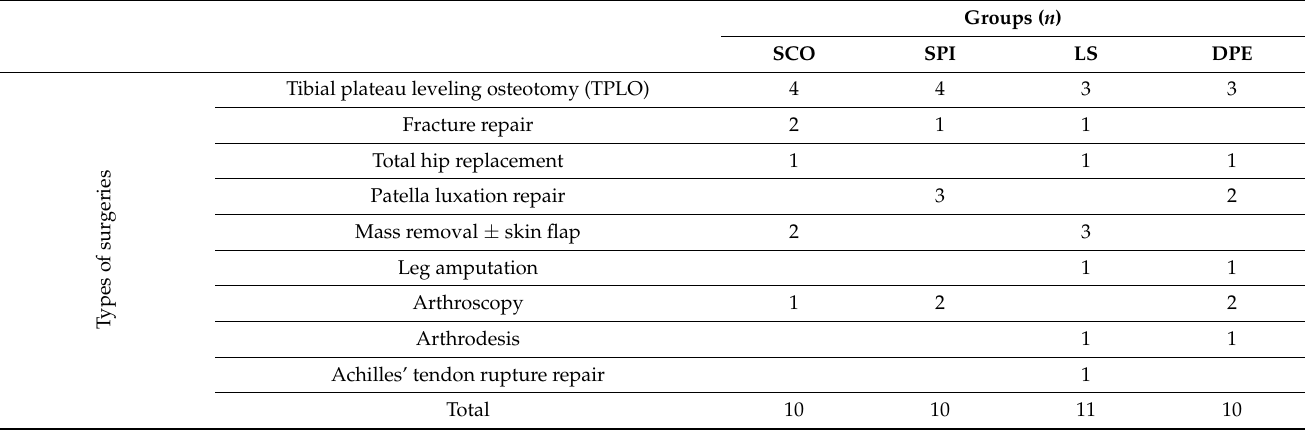
Table 1. Numbers ( n ) of surgical procedures performed in each of the study groups. SCO, epidural injection in the sacrococcygeal space; SPI, injection in the subarachnoid space; LS, epidural injection in the lumbosacral space; DPE, dural puncture epidural